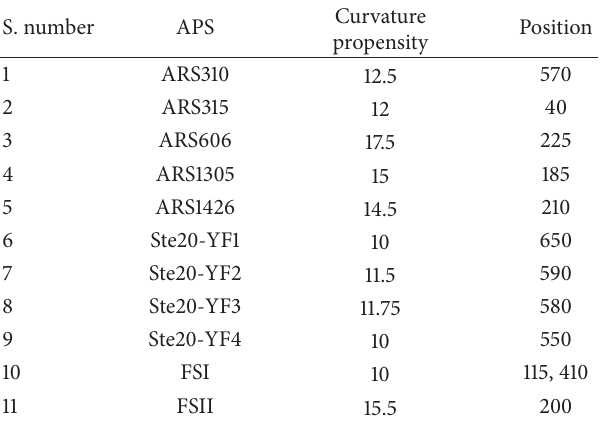
Table 10: Curvature propensity and bendability of APS sequences. S.